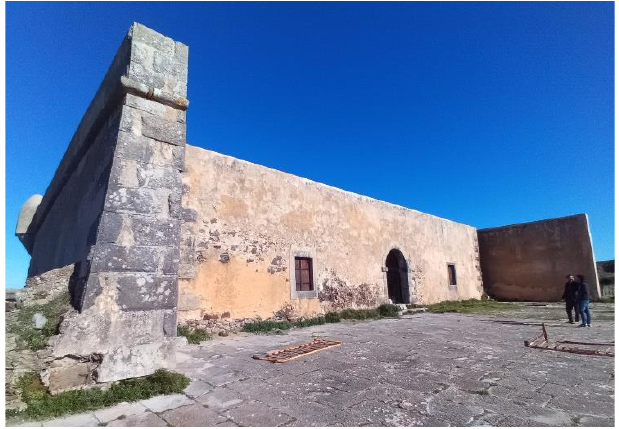
Figure 1. Paimogo’s Fort, in